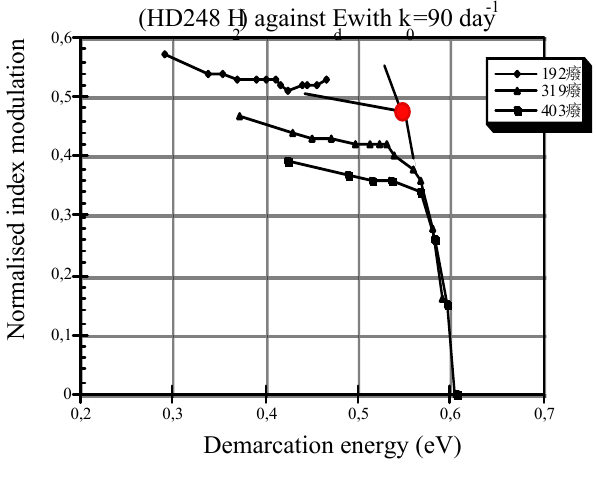
Figure 43. Corresponding master curve for low t and low T